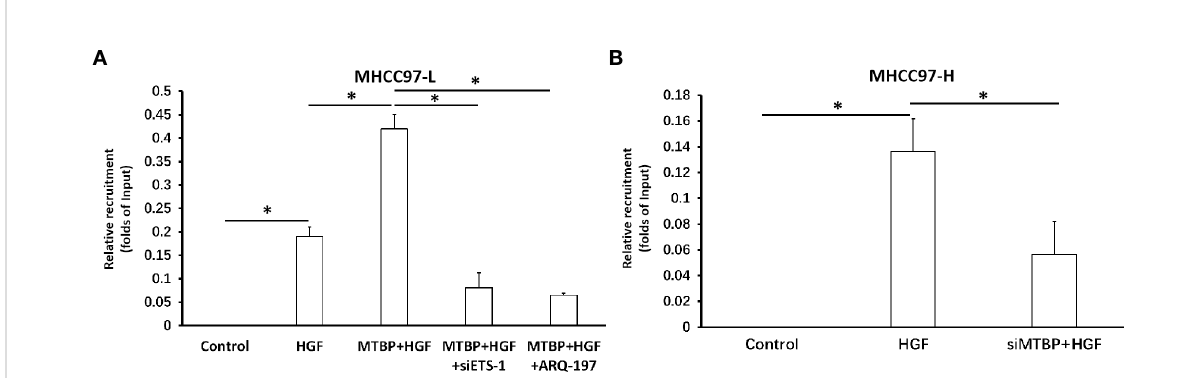
FIGURE 6 Effects of MTBP on the recruitment of ETS-1 to its downstream gene mmp1 ’ s promoter region. (A) The effect of MTBP overexpression in MHCC97-L cells on the on the recruitment of ETS-1 to its downstream gene mmp1 ’ s promoter region induced by HGF. (B) The effect of MTBP